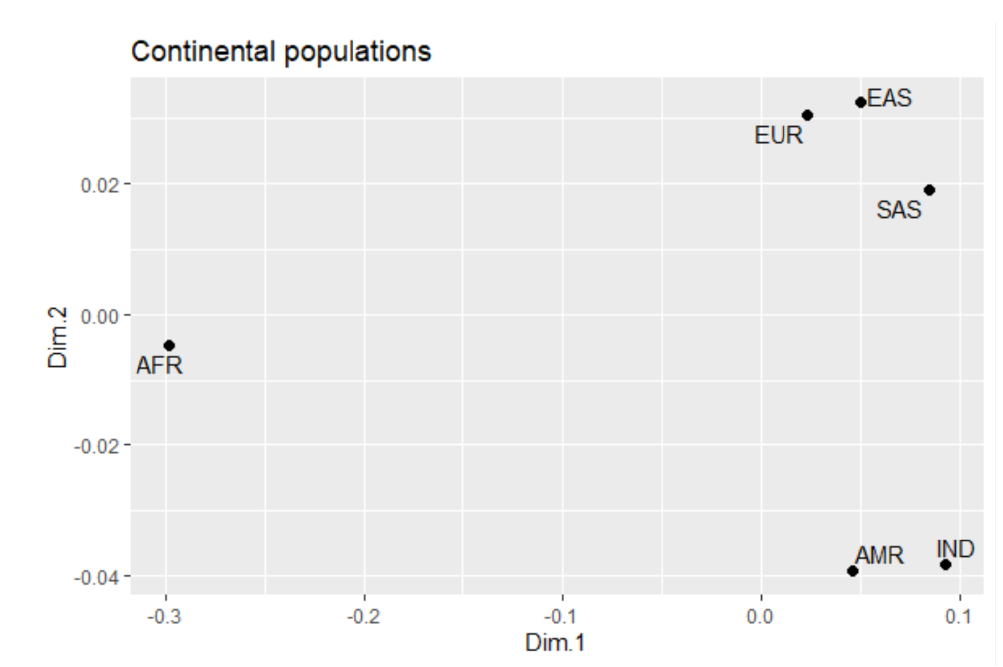
populations using Fisher’s exact test (Table 2). The molecular profile of the indigenous individuals of this study varies considerably from African, American, and European